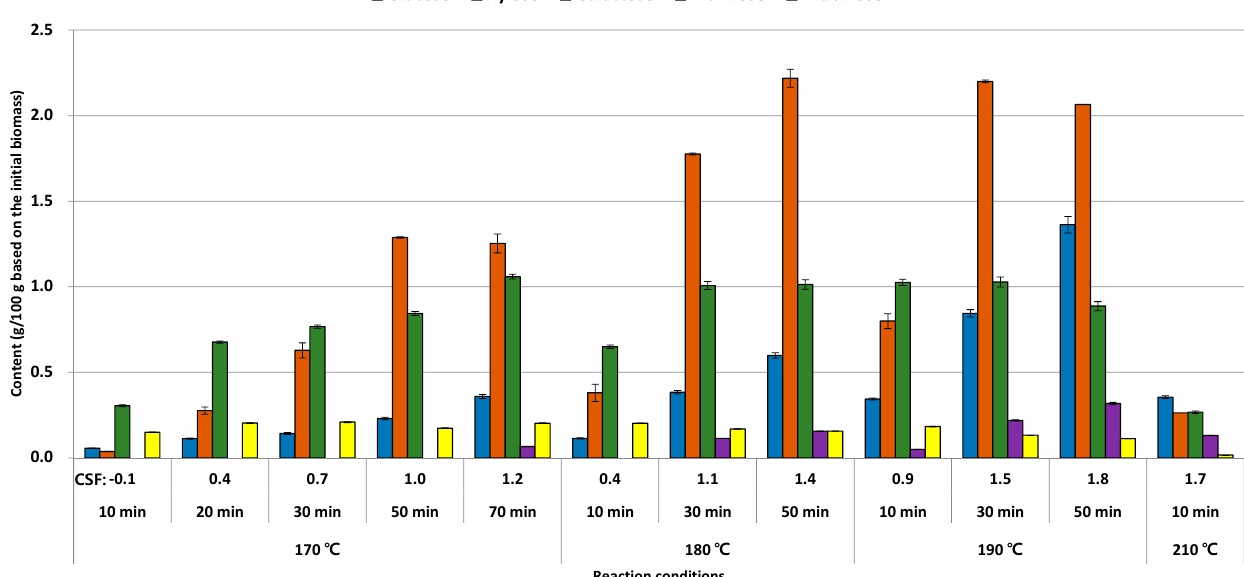
Figure 1. Monomeric sugar content (g/100 g initial biomass) of liquid hydrolysate after LHW treatment from E. pellita . Xylose was more released than glucose into the liquid hydrolysate, and the maximum content was 2.2% under conditions at 180 ◦ C for 50 min and 190 ◦ C for 30 min. The trend of glucose content which was increased as an extension of reaction time in the